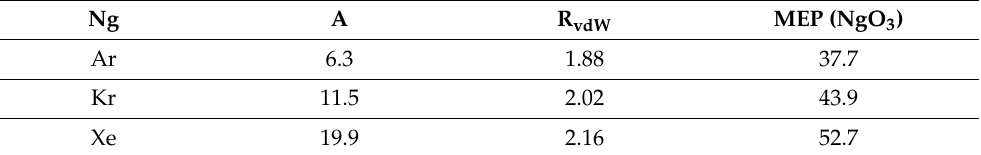
Table 9. Atomic polarizabilities ( α , a.u.) of noble gas (Ng) elements, van der Waals radii (in Å), and σ –hole MEP values (in kcal/mol) of their tetrafluoride derivatives at the MP2/def2-TZVP level of theory. The data regarding Ne are not shown owing to the instability of the NeO 3